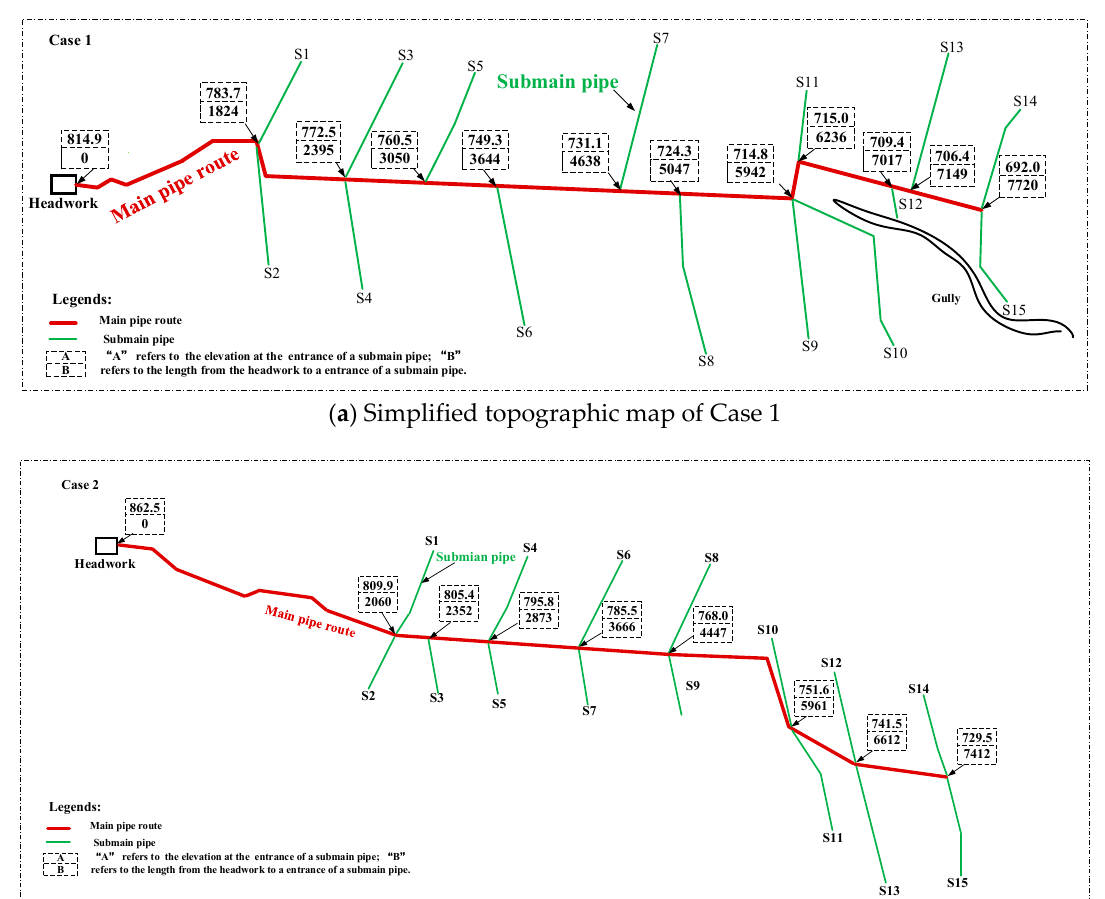
Figure 4. Simplified topographic maps of Case 1 and Case 2.